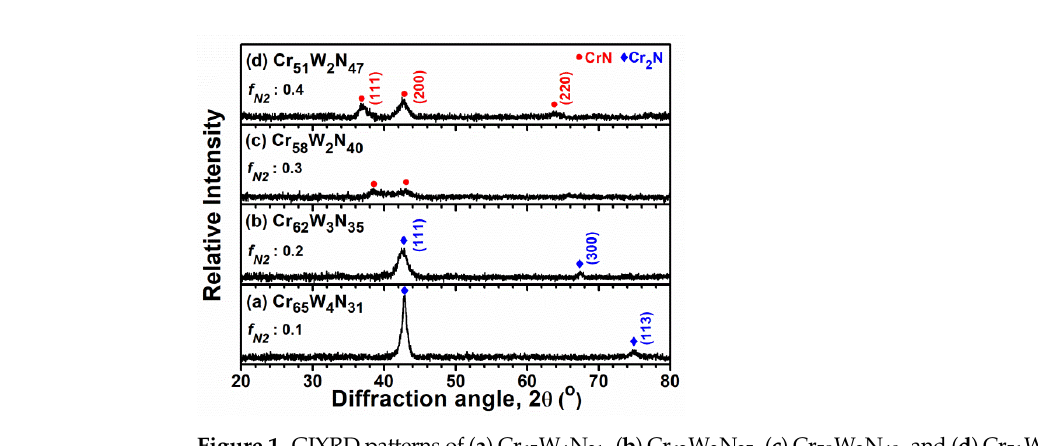
Figure 3. ( a ) XTEM and ( b ) HRTEM images of the Cr 51 W 2 N 47 coatings. Figure 4. Surface roughness values of the CrWN coatings.